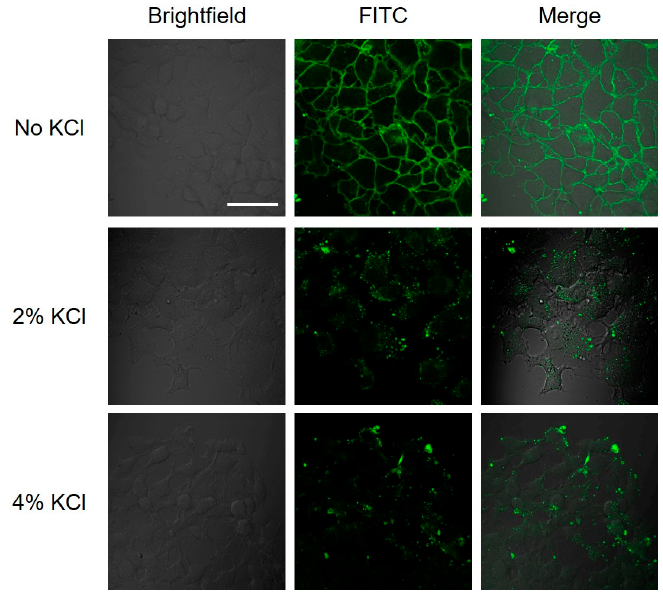
Figure 3. Confocal microscopy images of FL8V1-treated FaDu cells following a KCl wash. FaDu cells were incubated with 10 µ M of FL8V1 at 37 ◦ C (30 min) and washed with PBS (No KCl), 2%, and 4% were incubated with 10 µM of FL8V1 at 37 °C (30 min) and washed with PBS (No KCl), 2%, and 4% KCl solution; bar represents 50 µ KCl solution; bar represents 50 µm.